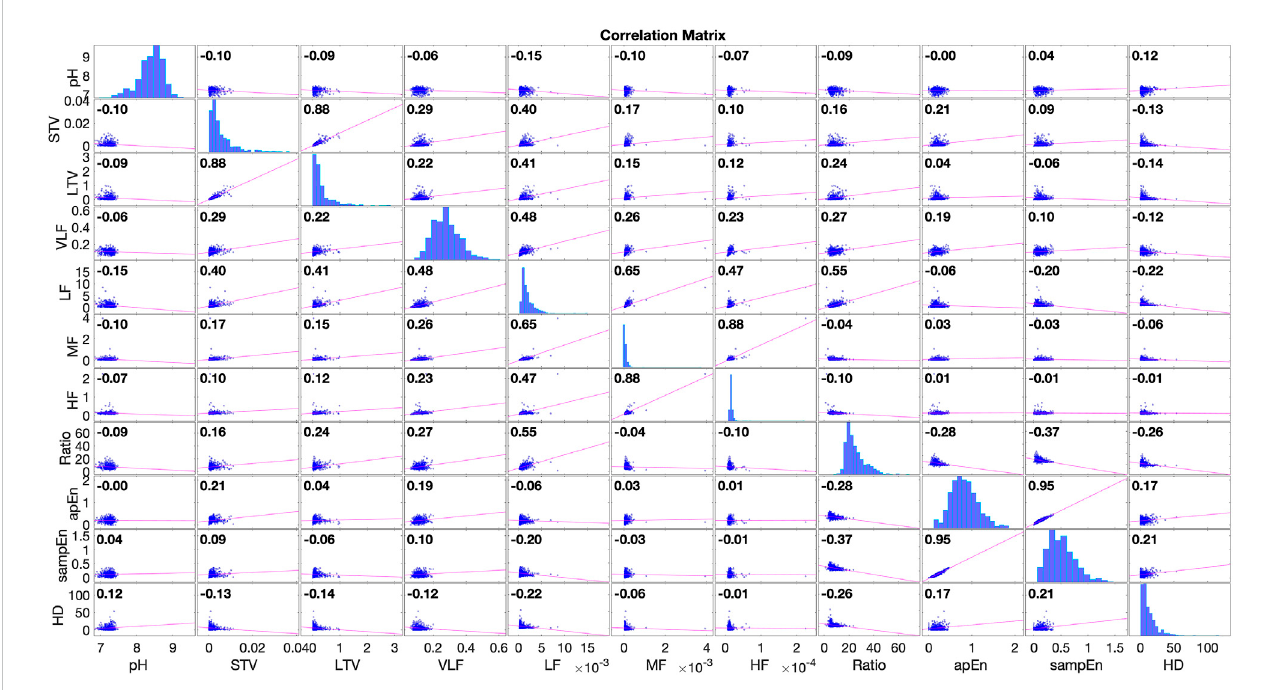
FIGURE 5 The correlation matrix of features and umbilical artery pH, computed with 552 CTG recordings in an open access CTG database described in Chudá č ek et al. (2014). The correlation coef fi cient between H ( M GP FHR , M GP UA ) , denoted as HD, and pH is comparable with popular features such as STV, LTV and LF. Meanwhile H ( M GP FHR , M GP UA ) is not highly correlated with other FHR